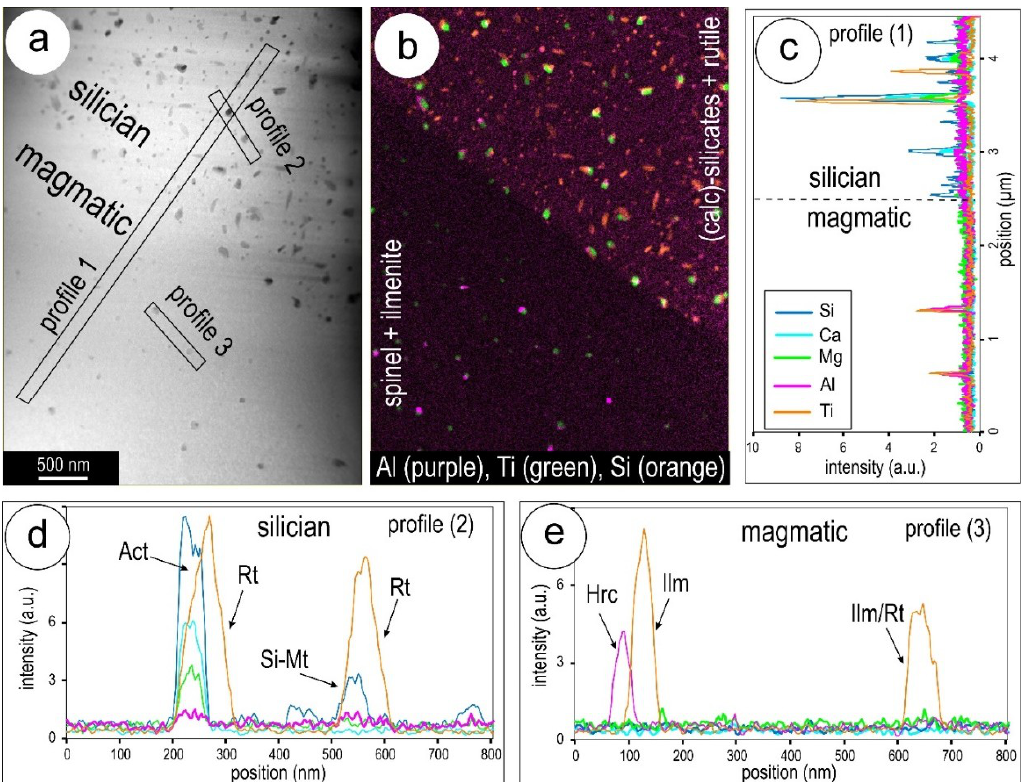
Figure 9. ( a ) HAADF STEM image of magnetite with silician and magmatic domains as marked (foil #6). Location of profiles 1-3 is also shown. ( b ) Overlap between Al, Ti and Si STEM-EDS maps showing the presence of distinct inclusions in the two domains as marked. ( c ) Profile across the two magnetite domains showing the sharp increase in Si, Ca, Mg signals in the silician domain, whereas Al is higher in the magmatic domain. The Ti signal is high in both but can be highest in the silician domain due to coarser rutile inclusions. ( d , e ) Profiles across inclusions from the silician and magmatic domains. Note presence of actinolite (Act), Si-Fe-nanoprecipitates (Si–Mt) and rutile (Rt) in ( d ). In ( e ), the Al-bearing spinel hercynite (Hrc) and ilmenite (Ilm) form composite inclusions.